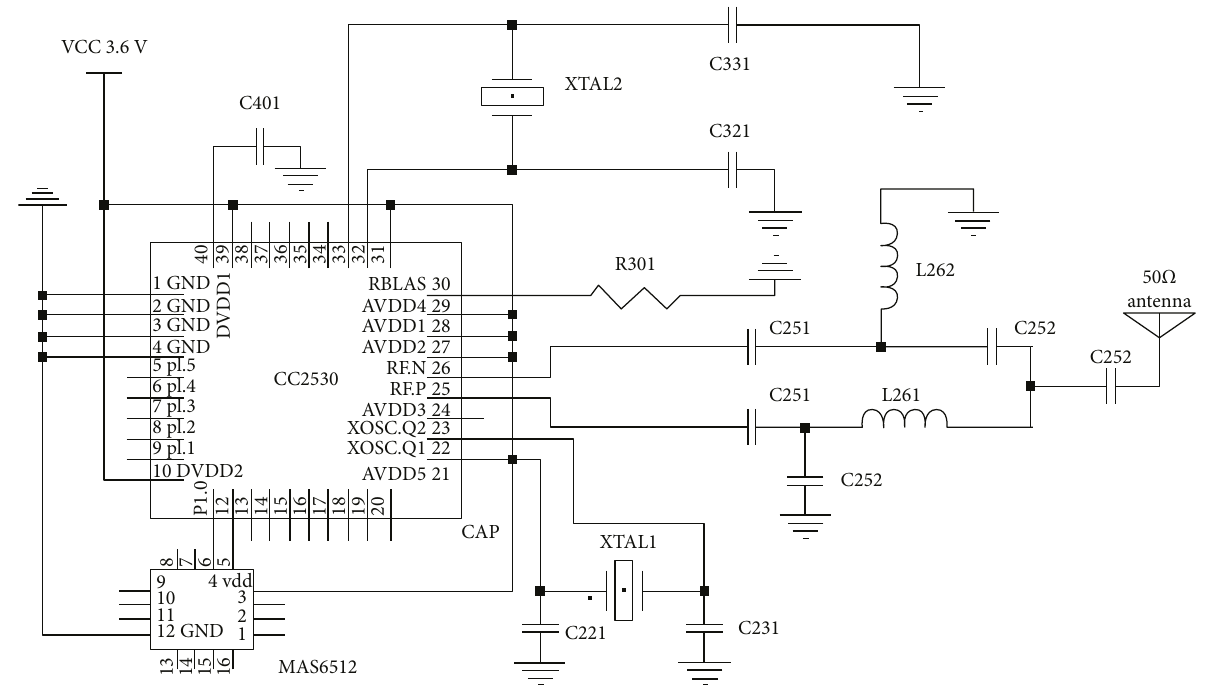
Figure 3: Pneumatic pressure sensor module.